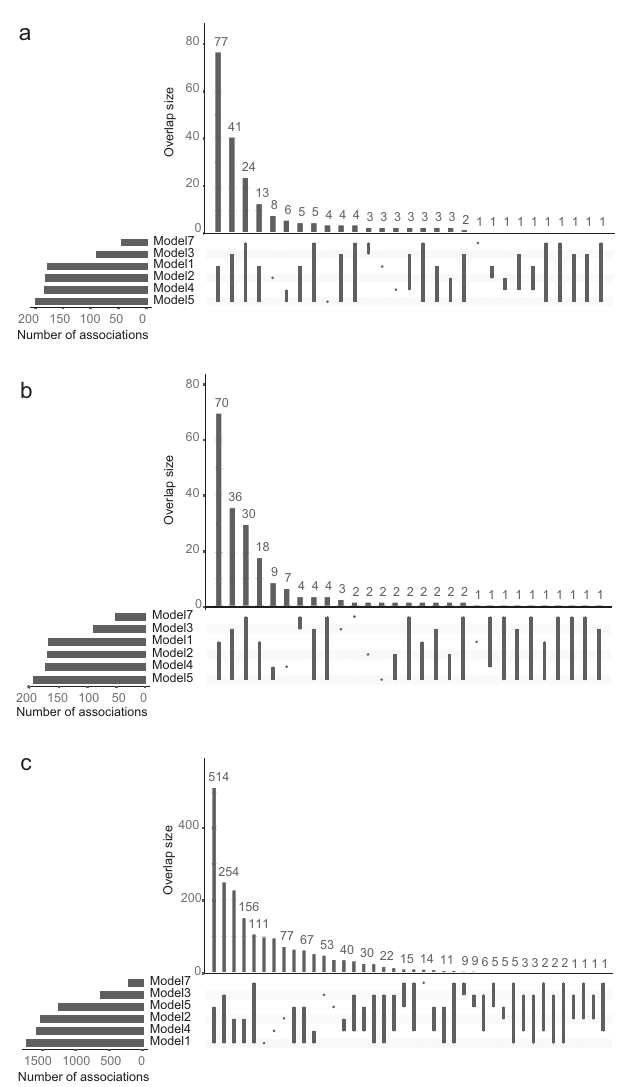
Fig. 6 Overlap between the total number of associations for the different SKAT model. The bars to the left represent the total number of associations per model, and the bars in the top (overlap size) the number of associations that overlap between the different models. a is the small SNV-sets (CDS-sets and Reg-sets) in the NSPHS, b the larger Flank- SNV-sets, and c the CDS-sets in the